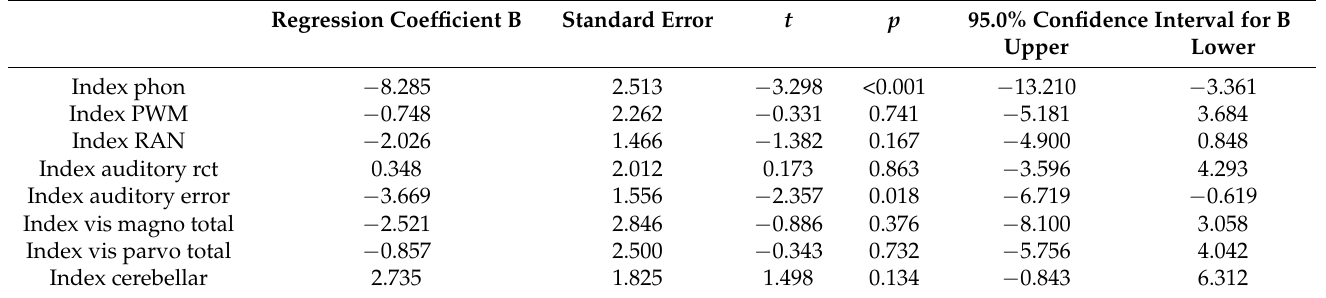
Table 8. The prediction of reading performance by a multiple linear regression analysis over the whole sample revealed two significant predictors: phonological awareness and auditory